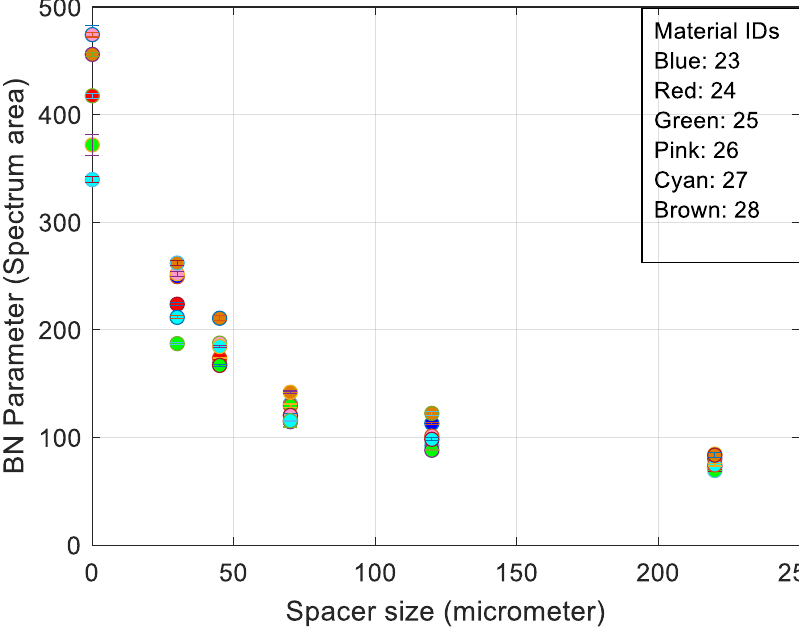
Figure 8. BN signal response, Spectrum Area for bottom surface in Transversal orientation.